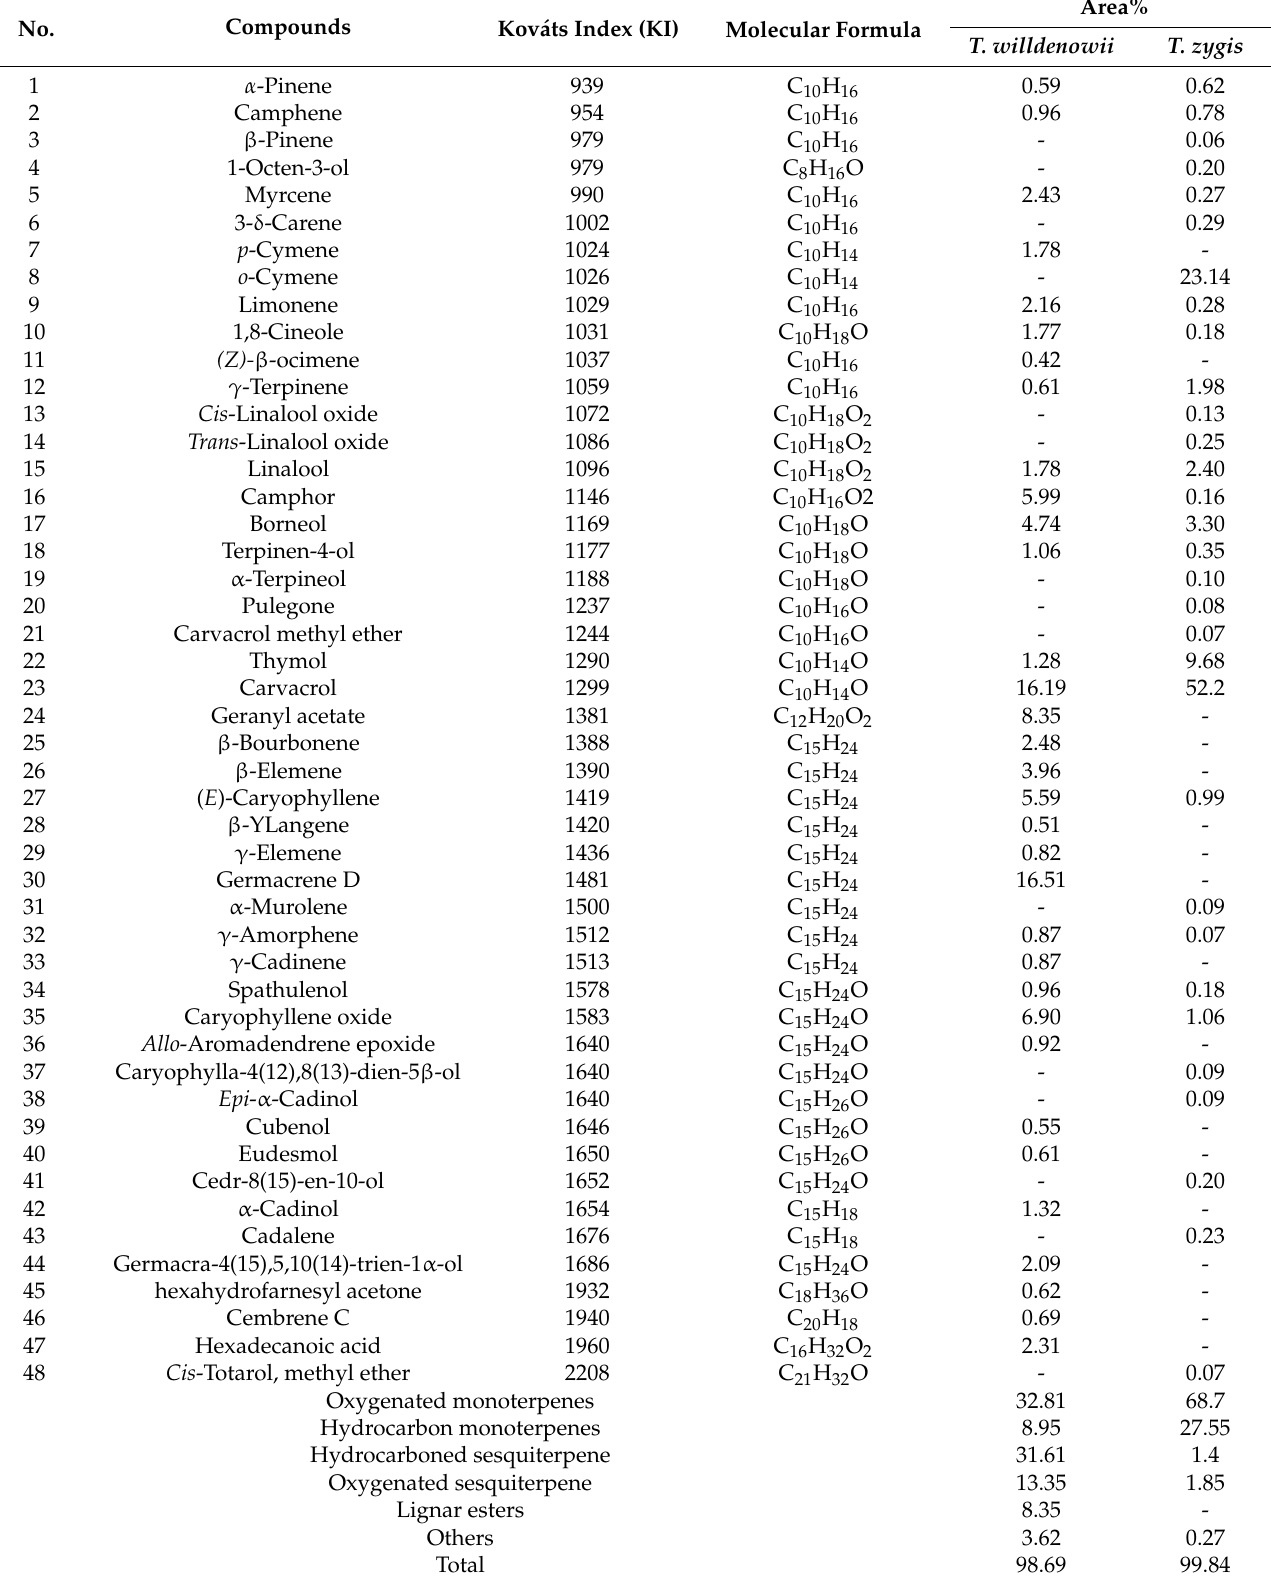
Table 3. Chemical composition of the thymes